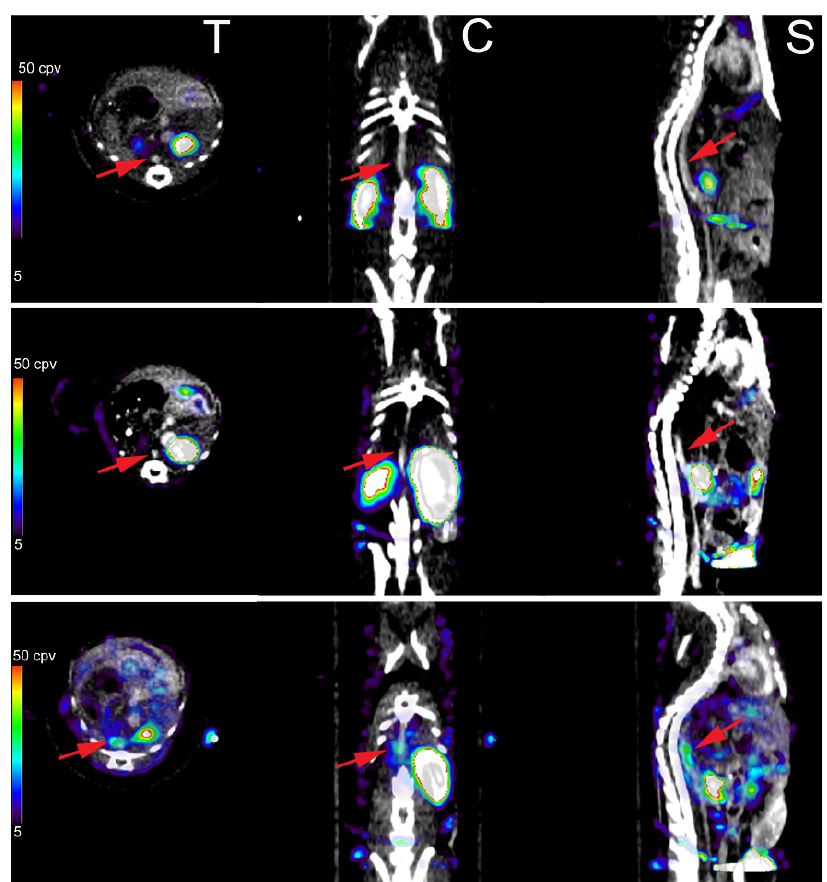
Figure 3. MMP-targeted imaging of vascular remodeling in abdominal aortic aneurysm. Examples of fused 99m Tc-P805 microSPECT and CT images of matrix metalloproteinase activation in abdominal aortae of a control mouse (( top ) row) and animals infused with angiotensin II to induce abdominal aortic aneurysm. A mouse infused with angiotensin II for 4 weeks that developed abdominal aortic aneurysm shows RP805 uptake in the aneurysm (( bottom ) row), whereas there is no notable tracer uptake in the abdominal aortae of the control mouse (top row) and an angiotensin II-infused mouse that did not develop aneurysm (( middle ) row). T: transvers, C: coronal, S: sagittal. Arrows point to abdominal aortae, identified by CT angiography. Published with permission of Wolters Kluwer Health from “Imaging vessel wall biology to predict outcome in abdominal aortic aneurysm”, Golestani, R., et al. Circ. Cardiovasc. Imaging 2015 , 8(1) , e002471